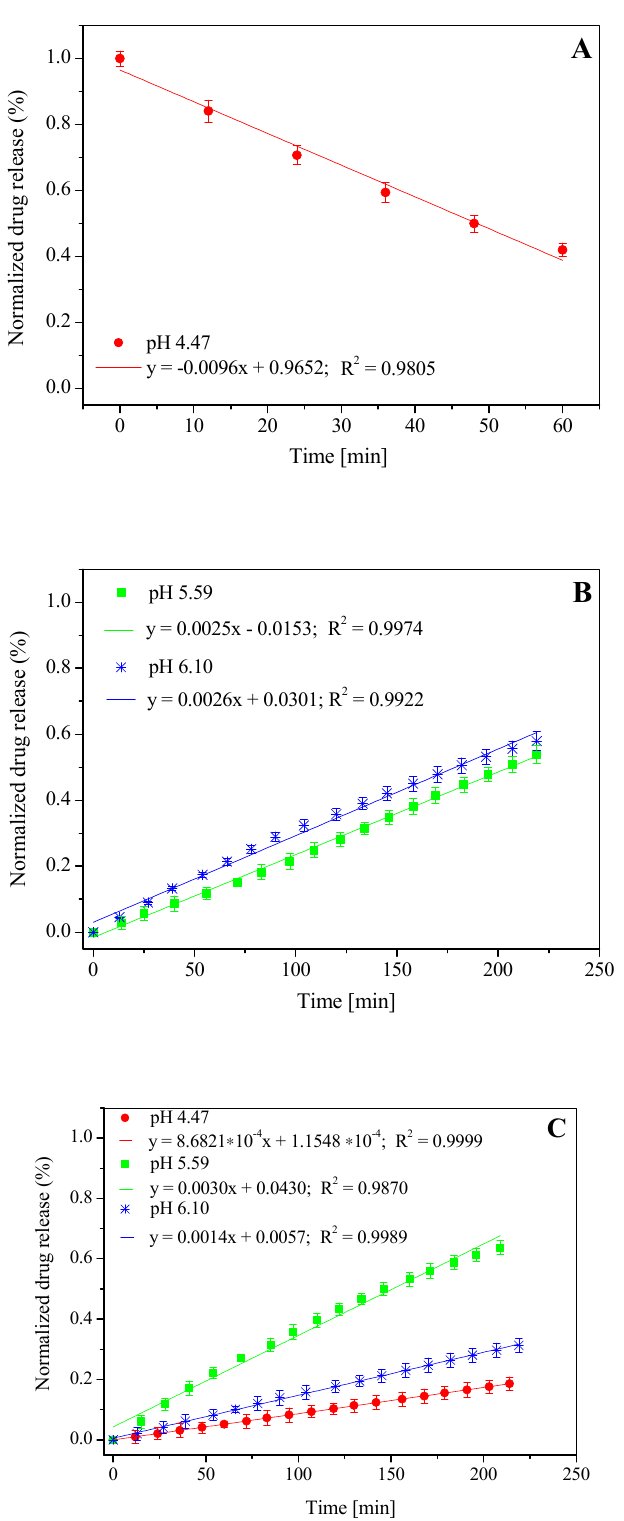
Figure 8. Release profile of 5-MBT from the L DPPC/5-MBT liposomes ( A , B ) and them complexes with albumin [L DPPC/5-MBT ]:HSA ( C ), at 37 °C, at initial time. Error bars represent standard deviation.